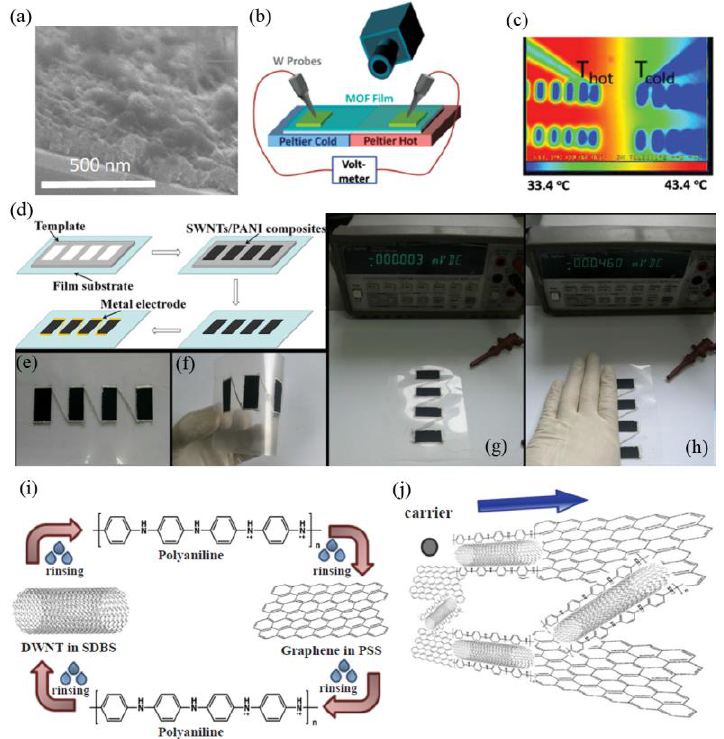
Figure 3. ( a ) Cross-section SEM image of an infiltrated tetracyanoquinodimethane (TCNQ)@Cu 3 (BTC) 2 thin film; ( b ) Schematic illustration of the TE measurement for metal-organic frameworks (MOF) thin film. An infrared (IR) camera is used to measure the temperature difference between heat side and cool side of the substrate and a multimeter is detected for the voltage generated between two of the metal contacts; ( c ) Example IR image taken during one of the measurements. Reproduced from [86] with permission; Copyright John Wiley & Sons, Inc. 2015; ( d ) Method for the preparation and assembly of the single-walled carbon nanotubes (SWCNTs)-polyaniline composite thin film TE module; ( e , f ) Photograph of fabricated flexible TE module; ( g , h ) Thermal voltage generation from the TE module before and after touching at one side of the module; Reproduced from [87] with permission; Copyright John Wiley & Sons, Inc. 2016; ( i ) Schematic illustration of the layer-by-layer self-assembly procedure of polyaniline/CNT/graphene multilayer film; and ( j ) carrier transport in these multilayer film. Reproduced from [88] with permission; Copyright John Wiley & Sons, Inc. 2015.